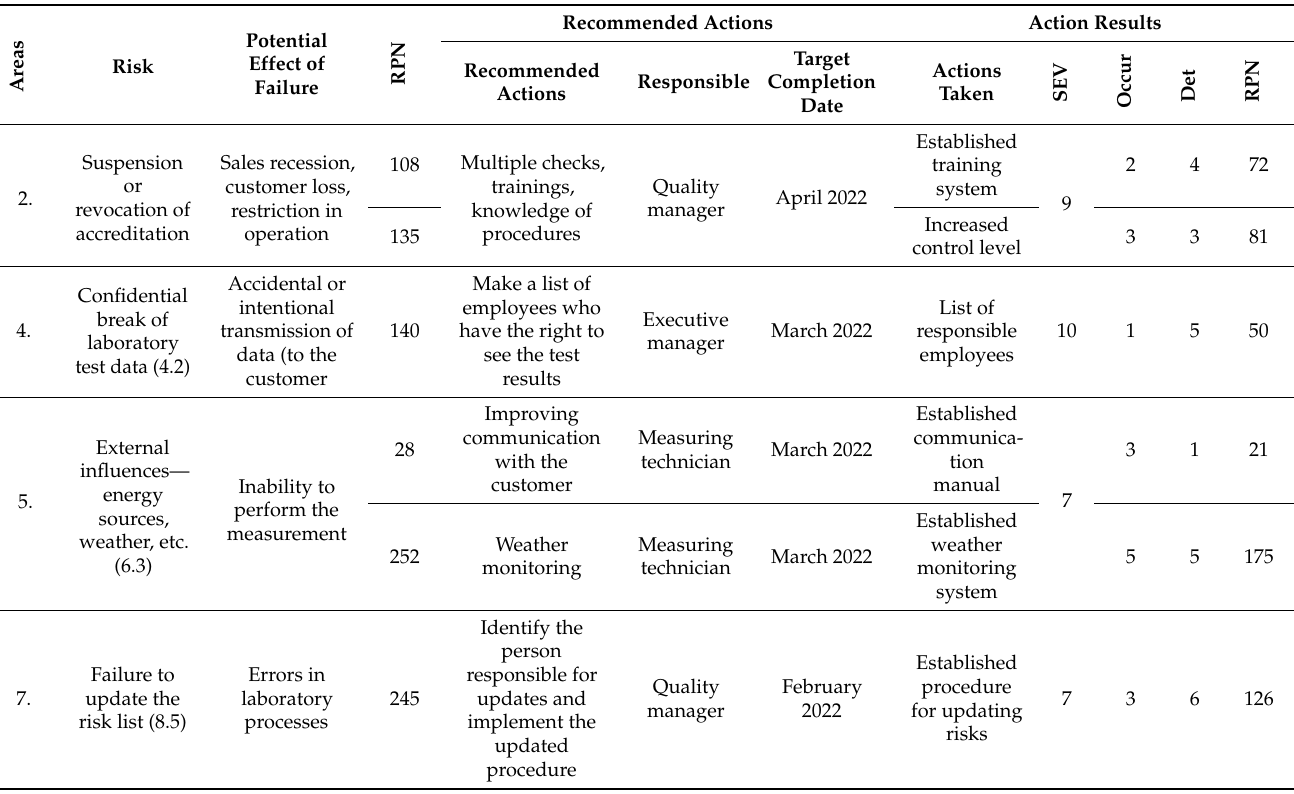
Table 6. FMEA—recommended actions.